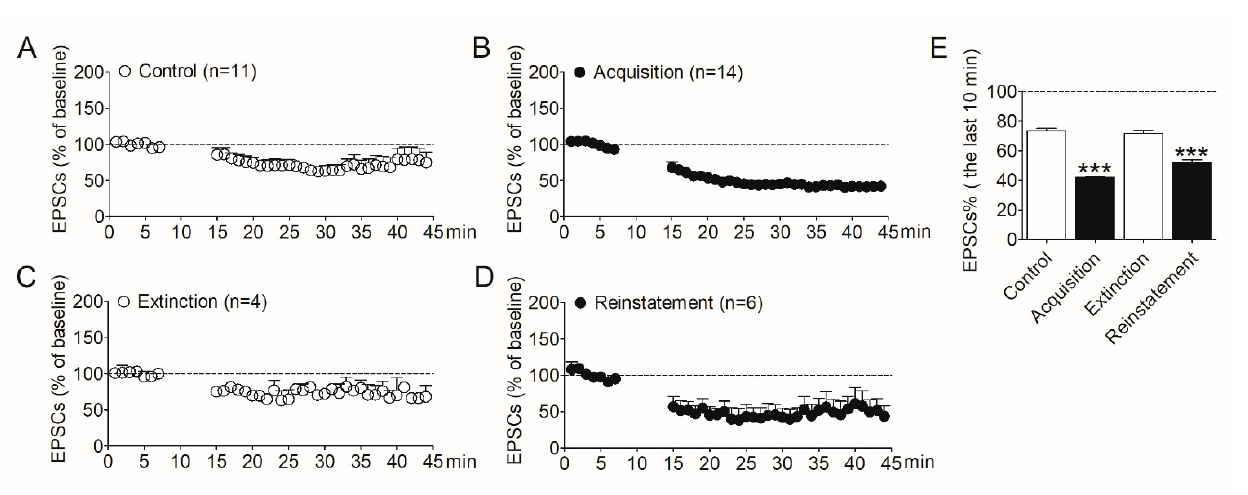
Figure 2. Alterations of LTD expression in the NAc shell were correlative to the addiction behavior in the animal model of morphine self-administration. ( A ) LTD was induced in the NAc shell in the control rats ( n = 11). ( B ) LTD induced in the NAc shell in the rats acquired morphine self-administration ( n = 14). ( C ) LTD induced in the NAc shell in the extinguished rats ( n = 4). ( D ) LTD induced in the NAc shell in the rats reinstated by morphine priming ( n = 6). ( E ) Average EPSCs (% of baseline) recorded in the last 10 min after LTD induction in the four groups. Asterisks indicate significant decreases of EPSCs in the acquisition and reinstatement groups compared to the controls (*** p <0.001). Data are expressed as mean ± SEM.